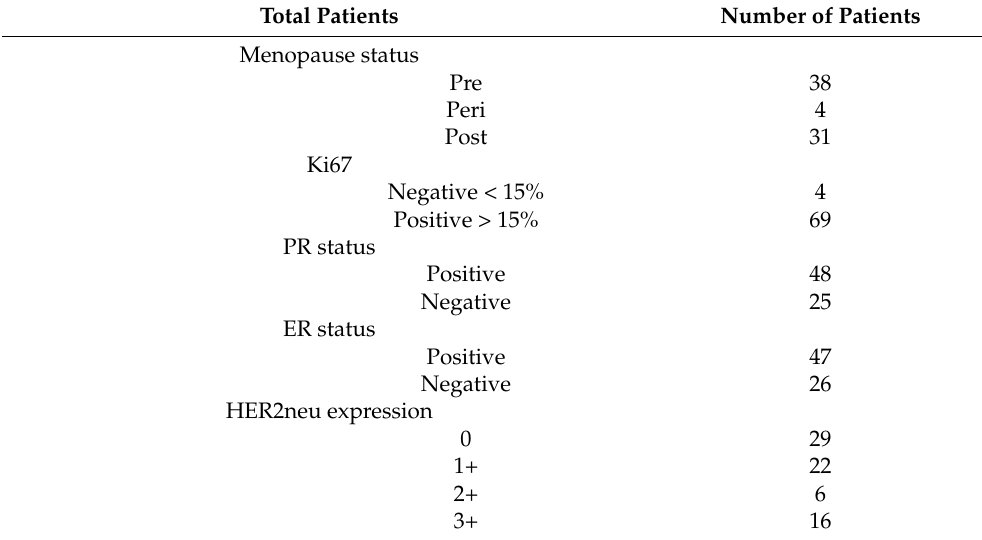
Figure 1. Example of a 47-year-old, triple-negative patient with pathological complete response after NACT: Primary tumor is clearly delineated in pretreatment breast MRI on T2w images ( A ) and post-contrast subtracted T1w images ( B ) and shows signal loss in the ADC map ( C ) and intense FDG uptake ( D ). In post-treatment breast MRI, no residual tumor can be detected on T2w images ( E ) or post-contrast subtracted T1w images ( F , G ). Post-therapeutic histopathology displaying focally accentuated sclerosing fibrosis and siderophages (lower right) but no residual invasive breast cancer (H&E, 50×). Table 1. Patient characteristics.